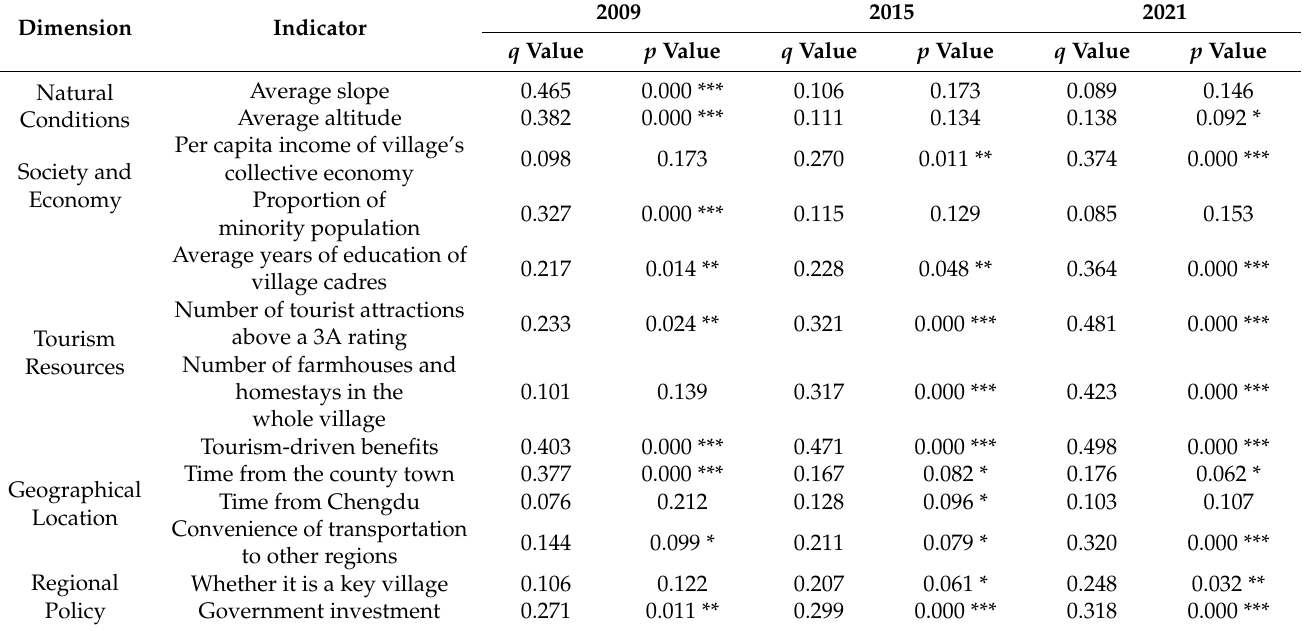
Table 3. Overview of detection and analysis of factors affecting land use for rural tourism in the study